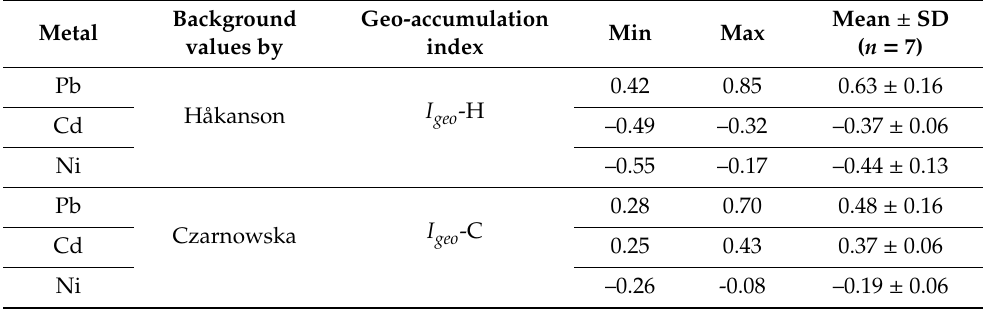
Table 6. Geo-accumulation indices for the particular heavy metals throughout Kampinoski National Park (7 sites, Figure